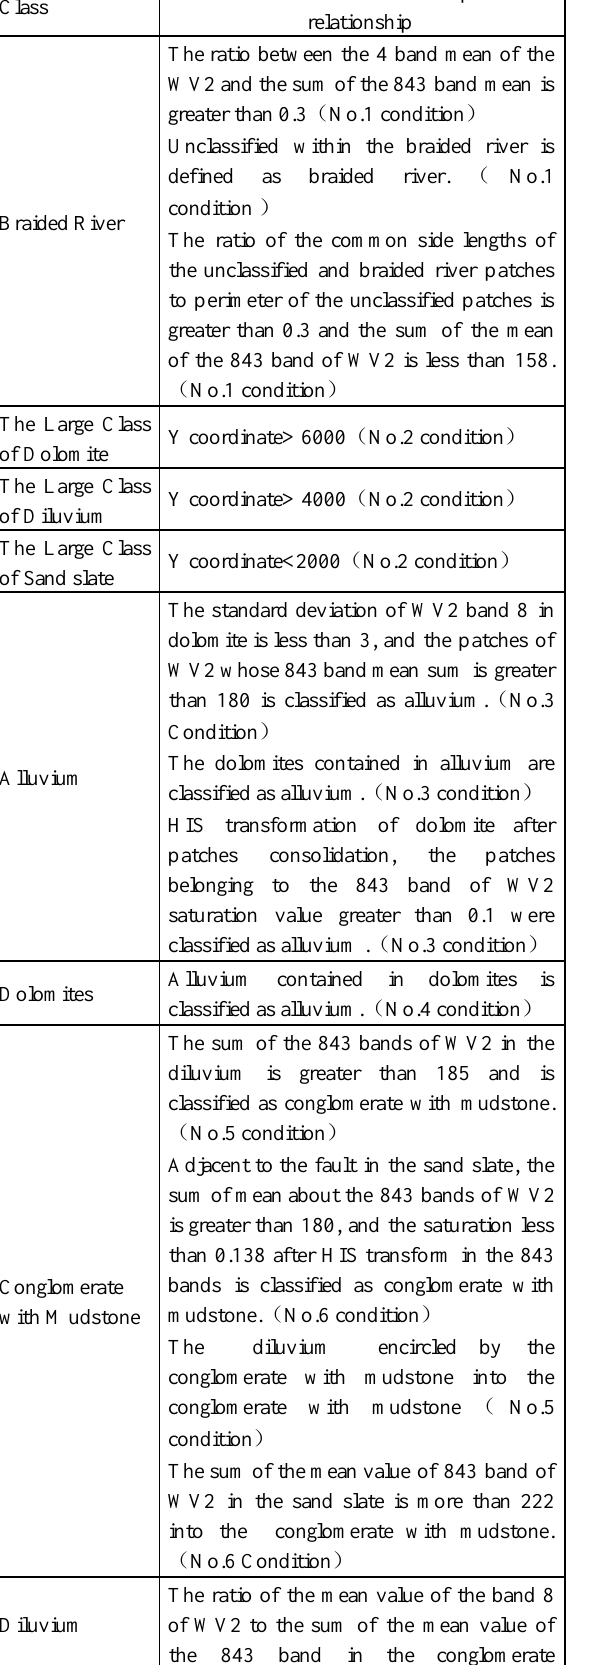
Figure 4. Geological information extraction flow chart